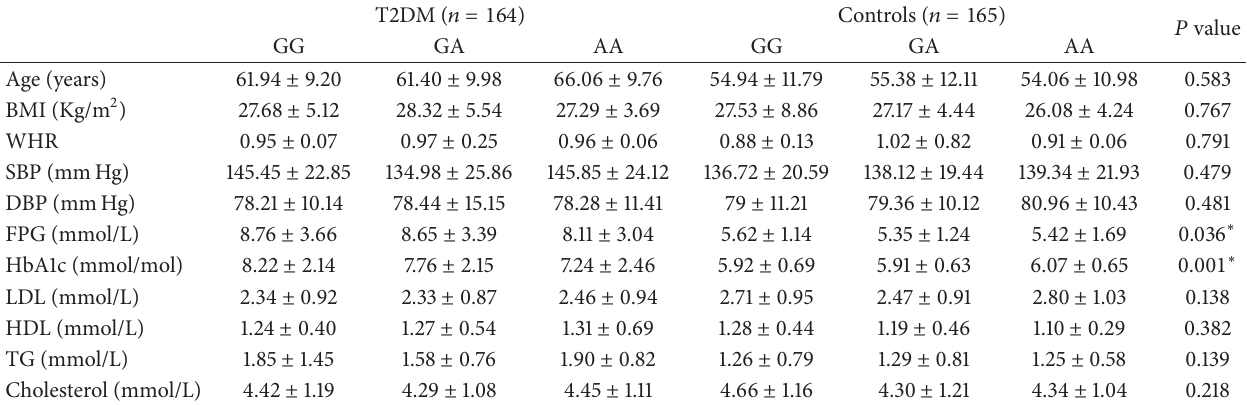
Table 3: Clinical and biochemical characteristics among subjects according to genotypes of R219K.